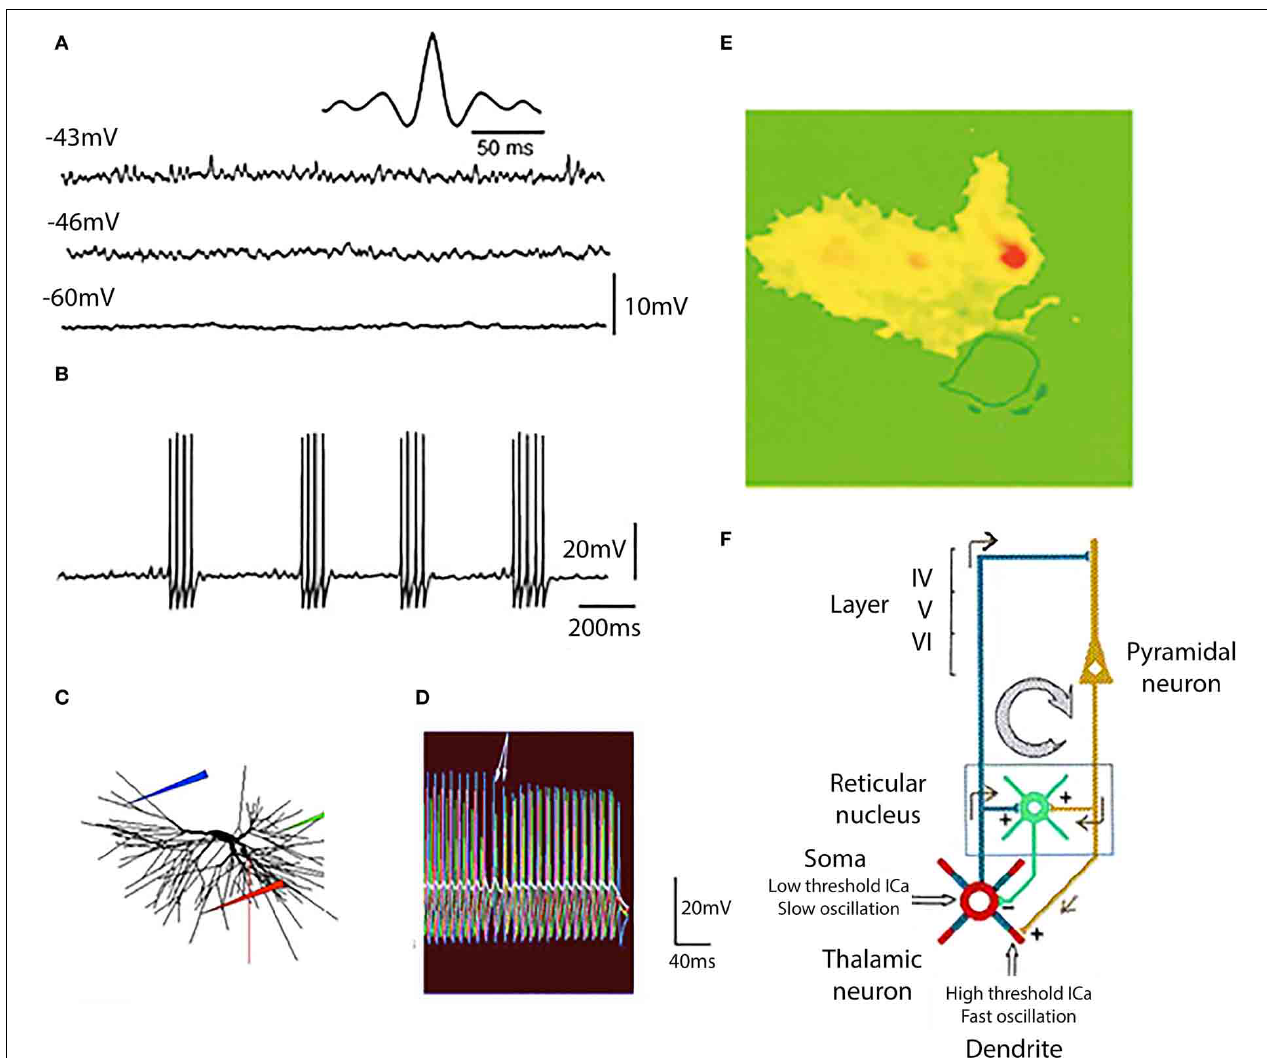
FIGURE 11 | Generation of gamma band oscillation by thalamic dendrites. (A) Three different levels of membrane potential are accompanied by a rapid membrane potential oscillation with clear gamma band frequency at − 46 and − 43mV. This is demonstrated by the dominant frequency at 37.5Hz at − 43mV as shown in the auto-correlogram (insert). (B) At a membrane potential of − 40mV action potentials were generated at the peak of each oscillatory wavelet and so the subthreshold oscillatory membrane properties are transformed into gamma band spike frequency projected via thalamocortical axons on to the cortical mantle. (C,D) The mechanism for this